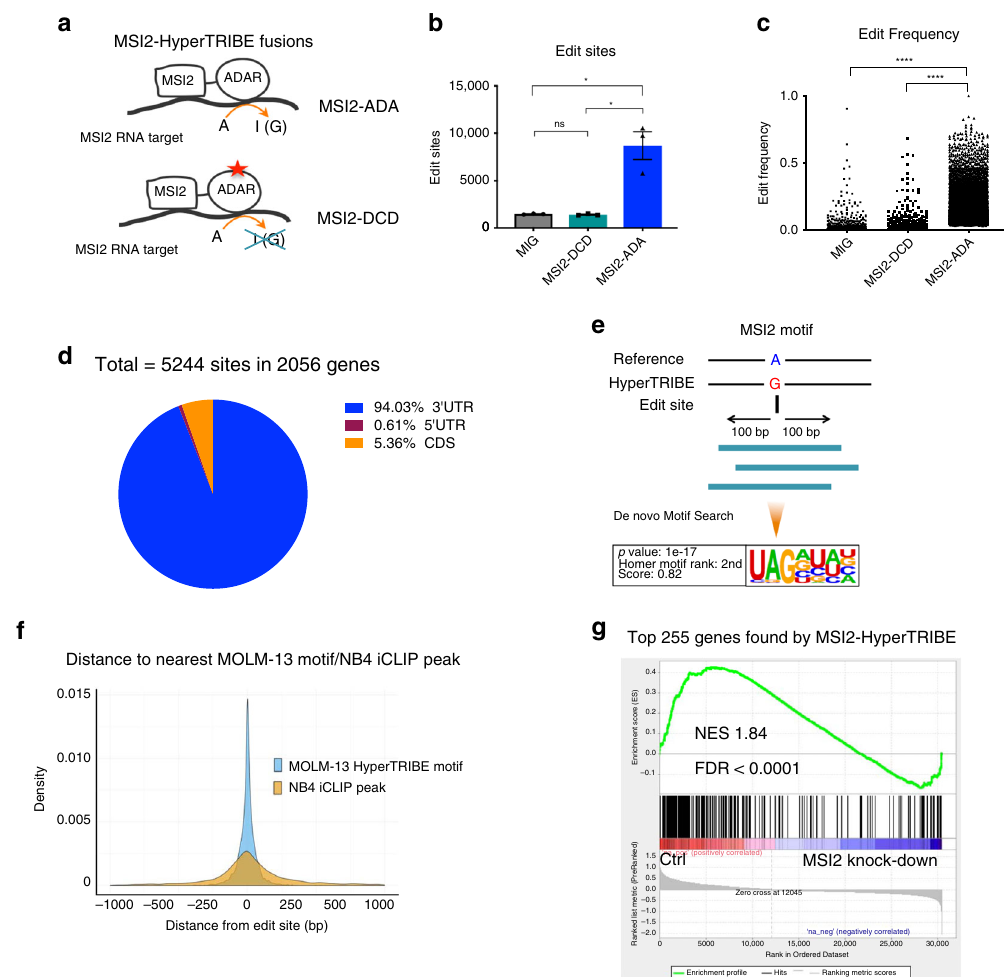
Fig. 1 MSI2-HyperTRIBE identi fi es MSI2 ’ s direct mRNA targets in a human leukemia cell line. a Schematic illustration showing the MSI2 protein fusion with the catalytic domain of hyperactive ADAR (MSI2-ADA) and the control fusion of MSI2 with the ADAR dead catalytic domain (MSI2-DCD). b Number of edit sites on mRNAs in MOLM-13 cells overexpressing MSI2-ADA or controls MSI2-DCD and empty vector (MIG). Data as means ± SEM of all the data points in three independent experiments. Two-tailed unpaired Student t test; * p < 0.05. c Edit frequency on mRNAs in MOLM-13 cells